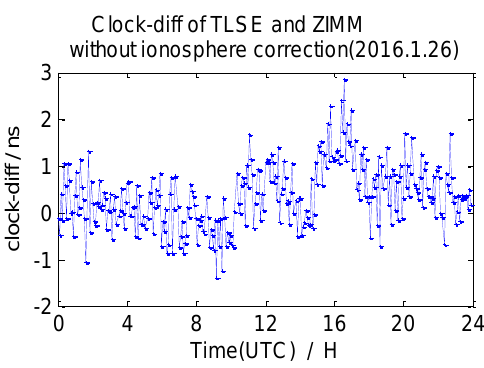
Figure 10. Clock difference between TLSE and ZIMM (without ionosphere correction).